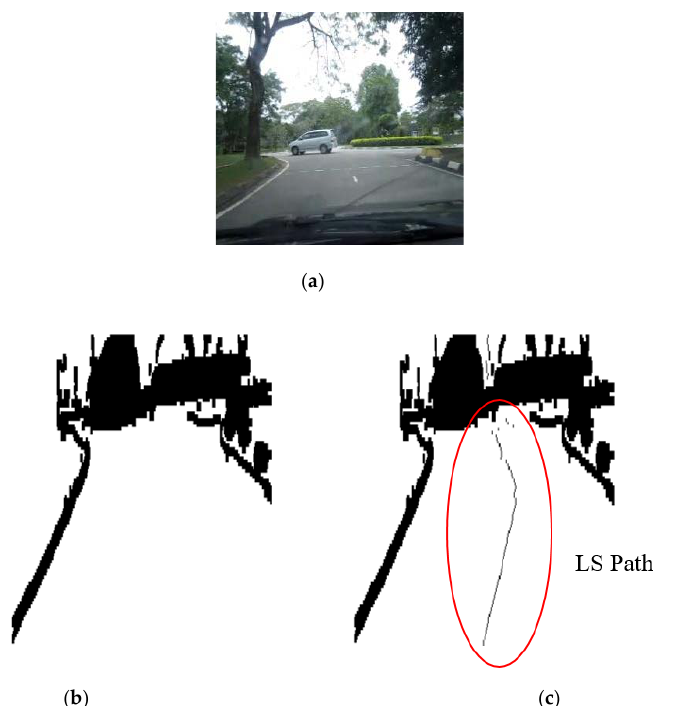
Figure 7. Image sequence with applying LS for roundabout determination at 50 m from the roundabout: ( a ) original image, ( b ) processing image, and ( c ) implementation of LS (continuous dotted line at the middle).